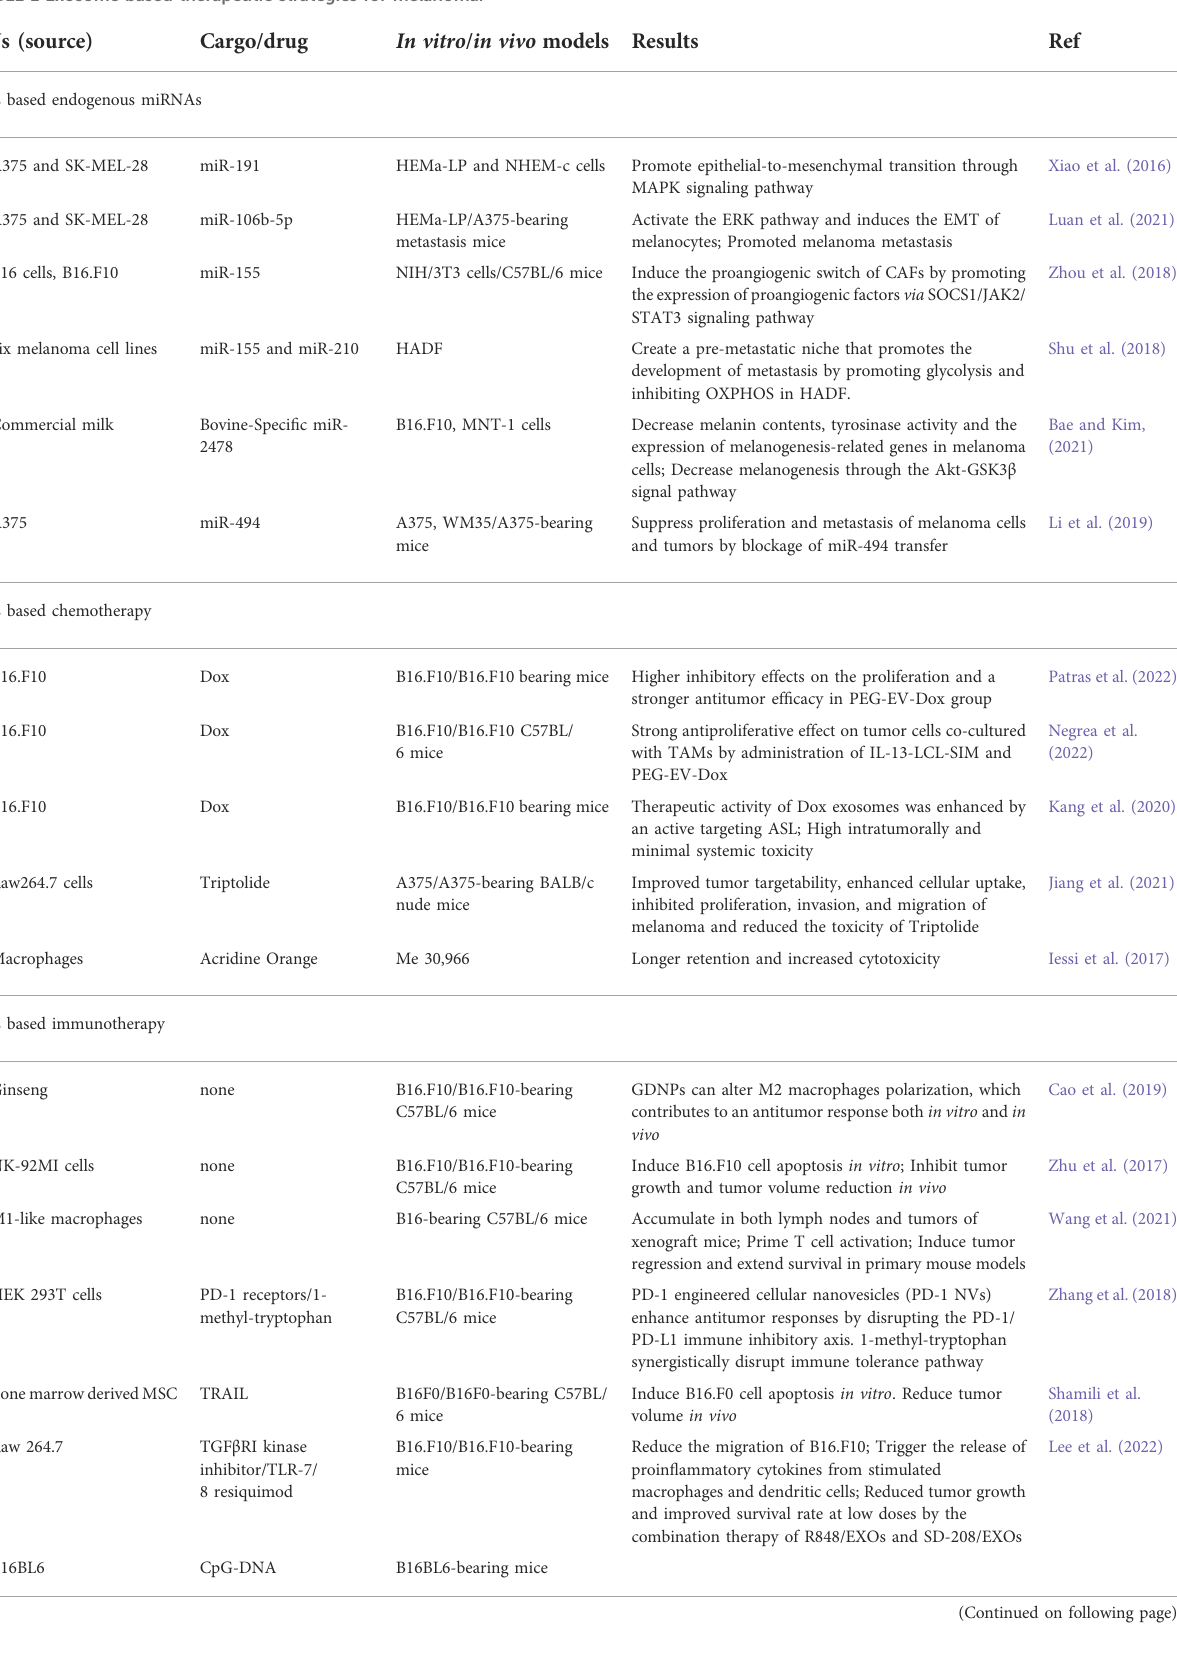
TABLE 1 Exosome based therapeutic strategies for